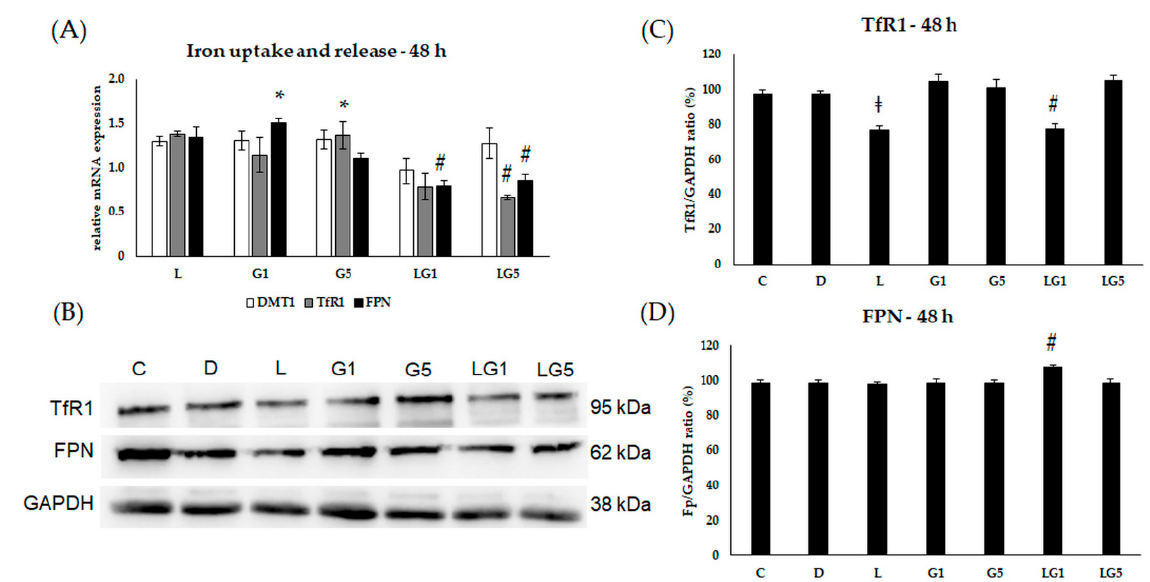
Figure 7. Determination of mRNA expression ( A ) and protein ( B – D ) levels of TfR1, DMT1, and FPN after lutein and Glu treatments of the SH-SY5Y cells at 48 h. SH-SY5Y cells were treated with 10 ng/µL of lutein, 1 mM, 5 mM Glu, lutein with Glu together to detect the changes in the expression of TfR1, DMT1, and FPN. The gene expression measurements were performed by SYBR Green RT-PCR protocol using β -actin as a housekeeping gene. The relative expression of controls was regarded as 1. The protein expression measurements were performed by semi-dry Western blotting using GAPDH as a loading control. The protein’s OD was expressed as a percentage of the target protein/GAPDH ratio. The bars represent the mean values ( ± standard deviation error bars, SD) of three independent experiments ( n = 3) performed in triplicate and are presented relative to their control cells. The * marks the statistical significance of Glu treatments compared to control, ‡ shows the statistical significance of lutein treatments compared to control, # signs the statistical significance of combined (lutein with Glu) treatments compared to the Glu treatments at 48 h ( p < 0.05). Based on our results of the 72 h measurements, both 1 mM and 5 mM Glu concentra- tions significantly increased the relative mRNA expression of TfR1, while lutein alone and in culturing together with Glu downregulated the expression of TfR1 (Figure 8A). Protein expression of TfR1 was downregulated in the lutein-treated cells and reduced further when Glu was cultured together with lutein. Indeed, 1 mM Glu treatment increased the TfR1 protein expression, while 5 mM Glu decreased it. (Figure 8B,C). The FPN relative mRNA expression remained unchanged in the 72 h experiments (Figure 8A). The protein analyses of FPN showed a slight decrease when lutein was added to the cells together with 1 mM or 5 mM Glu (Figure 8B,D). The relative mRNA expression of DMT1 elevated after 5 mM Glu treatment and decreased when lutein was also present in the media (Figure